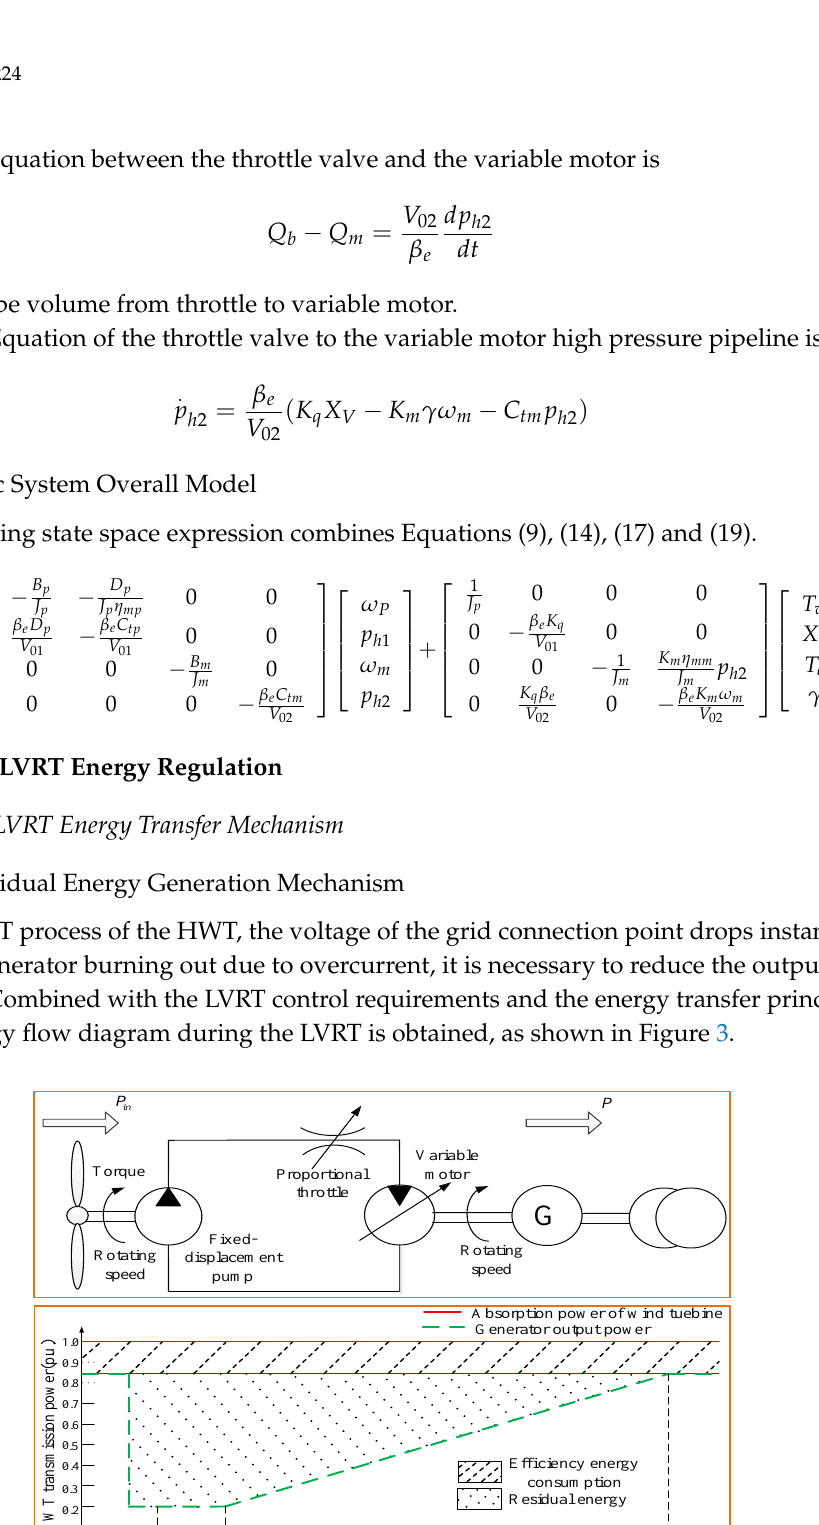
12 13 Figure 4. LVRT energy transmission variation rule. During LVRT, the HWT’s regulation of the remaining energy is divided into three phases: the primary phase, the transition phase, and the recovery phase. In the primary stage (t = 0 s~0.625 s), the grid voltage drops rapidly, and the output power of the generator set is required to be quickly adjusted to consume the remaining energy of the HWT. In the transition phase (t = 0.625 s~2 s), the grid voltage is gradually recovered, and the generator set is required to output low power to permit inertial energy storage and recover the energy of the HWT. In the recovery stage (t = 2 s~12 s), the power grid is cut off, and the HWT is required to gradually release the stored energy, so that the HWT output power is gradually recovered at a rate of 10% of rated power per second. 3.2. LVRT Energy Layered Control Based on the mechanism of residual energy transfer during low voltage power transmission, an energy hierarchical control strategy is proposed, in which the residual energy is regulated by